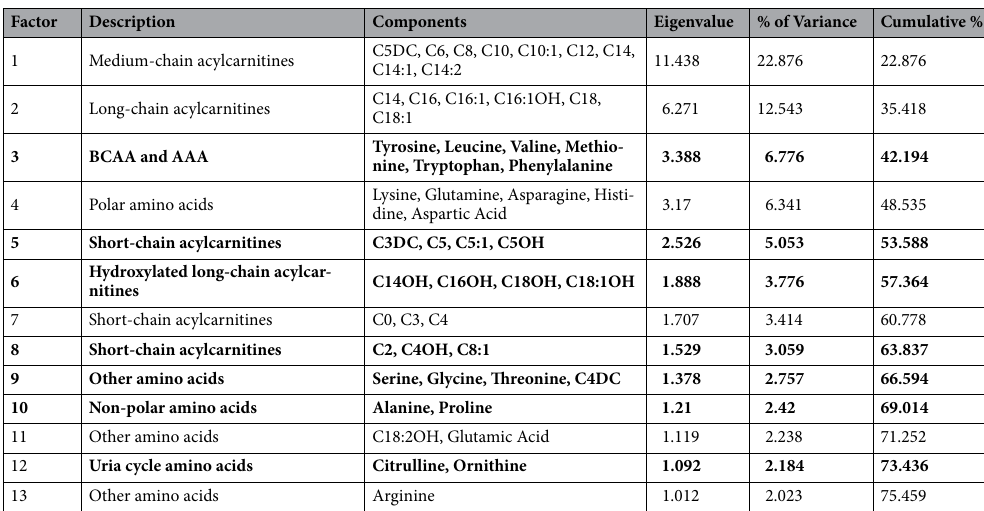
Table 2. Principal Component Analysis (PCA). The table lists of factors identified by PCA and the associated individual components, description, eigenvalue and variance. BCAA: Branched-chain amino acids, AAA: Aromatic amino acids. Significant values are in bold.